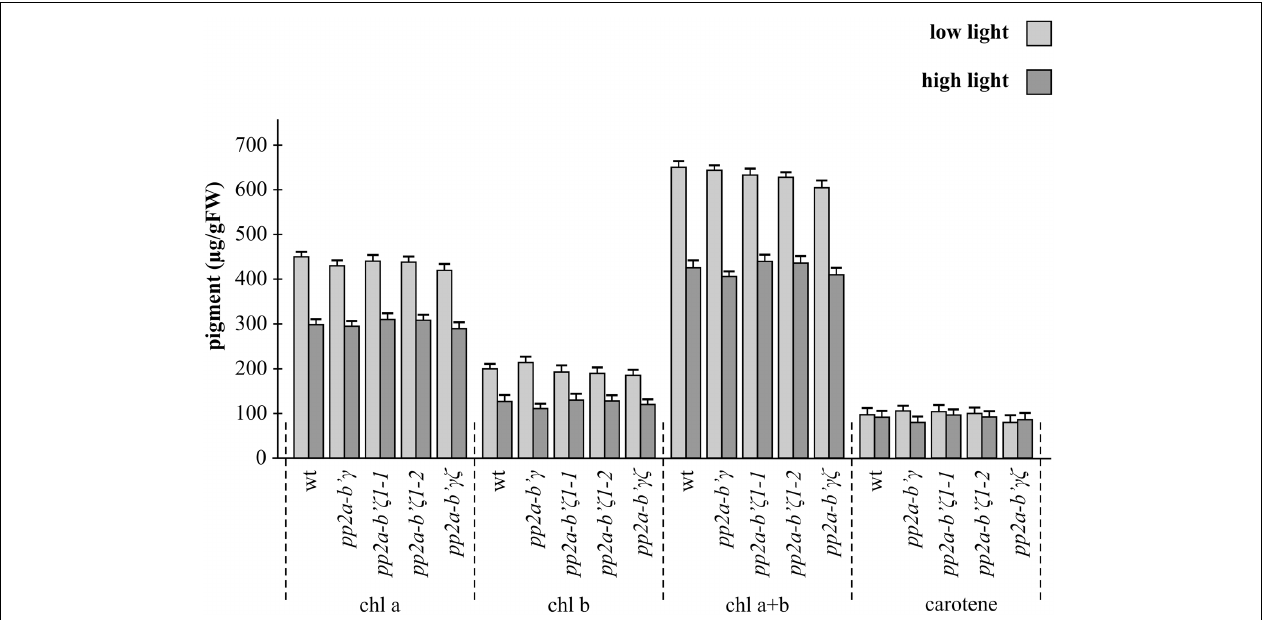
FIGURE 4 | A comparison of the leaf pigment contents in the pp2a-b’ γ , pp2a-b’ ζ 1-1 , pp2a-b’ ζ 1-2 , and the pp2a -b’ γζ double mutant grown under either low or high light conditions. Chlorophyll a (chl a), chlorophyll b (chl b), total chlorophyll (chl a + b) and total carotenoid pigments (carotene)